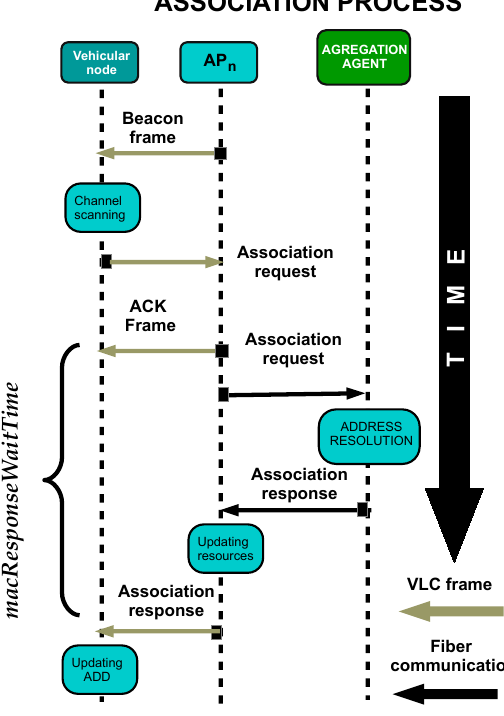
Figure 2. Diagram of the association process in the standard